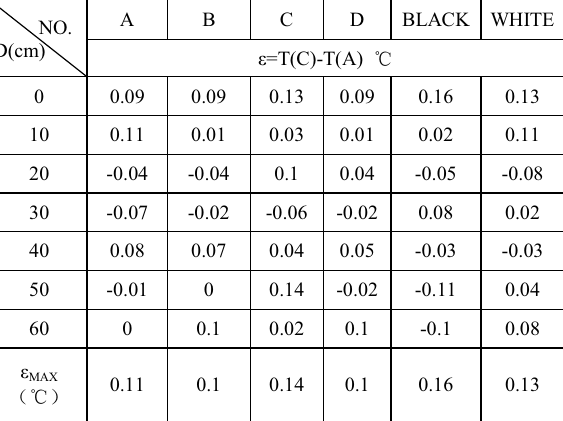
Figure 5. T(C), T (A) of black and white skin The errors of the infrared temperature measurement system, based on distance compensation of four yellow skins, a simulated black skin, and a simulated white skin have been shown in table 2, where D(cm) is the distance between the temperature measurement system and the irradiated part of the subject, (cid:166) is the error between the forehead temperature T(C) measured by the infrared temperature measurement system based on distance compensation and the actual temperature value T(A) measured by Microlife FR1DM1, (cid:166) MAX ( (cid:263) ) is the maximum error between T(C) and T(A). It could be seen that the temperature measurement accuracy of the infrared temperature measurement system based on distance compensation has been improved, and the maximum measurement error in the range of 0-60cm is kept within 0.2 (cid:263) and the measurement result has not affected by the skin color. Table 2. Error of forehead